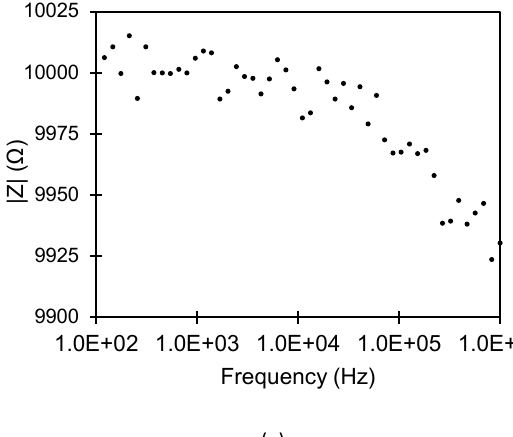
Fig. 2. Electrode configuration. Z x represents board impedance measurement. H_CUR and L_CUR are connected to ground electrodes, while H_POT and L_POT are the sense electrodes.